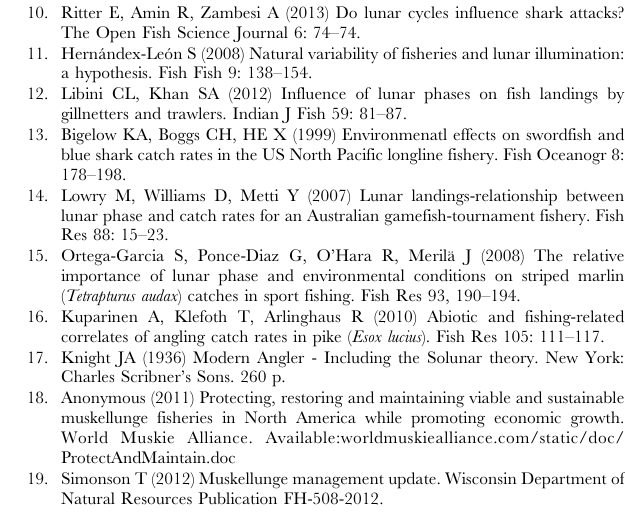
Figure S1 Location of muskellunge catch records. Coordinates for the location of the water body for Canadian records and for the centroid of the county for U.S. records. Figure S2 Simulated patterns for periodic regression models with two lunar predictors. For each simulation, a was set at 4; x 1 and x 2 were set at 4. The lunar cycle starts at 0001 h on the morning after the full moon. Figure S3 Effect of the number of model predictors on the model strength for a randomly selected sample of lunar days. Each bar represents the mean R 2 value ( 6 95% CI) for 100 runs of the model y=a + xcosine2 h , where y = number of fish caught and h is the angular equivalent of lunar day. Models were run on a randomly-selected sample of 50,000 lunar days from 1 to 29 (on which a simulated fish was ‘‘caught’’).